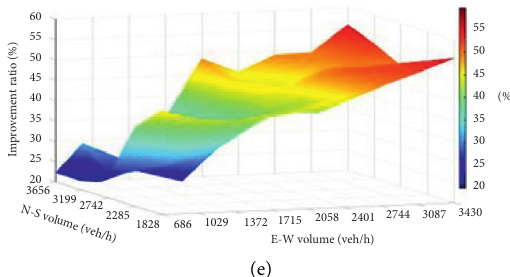
Figure 13: Improvement ratios of the left-turning time at the west entrance. (a) Scheme 1. (b) Scheme 2. (c) Scheme 3. (d) Scheme 4. (e) Scheme 5. E-W volume means the same traffic volume of east entrance and west entrance. N-S volume means the same traffic volume of north entrance and south entrance.